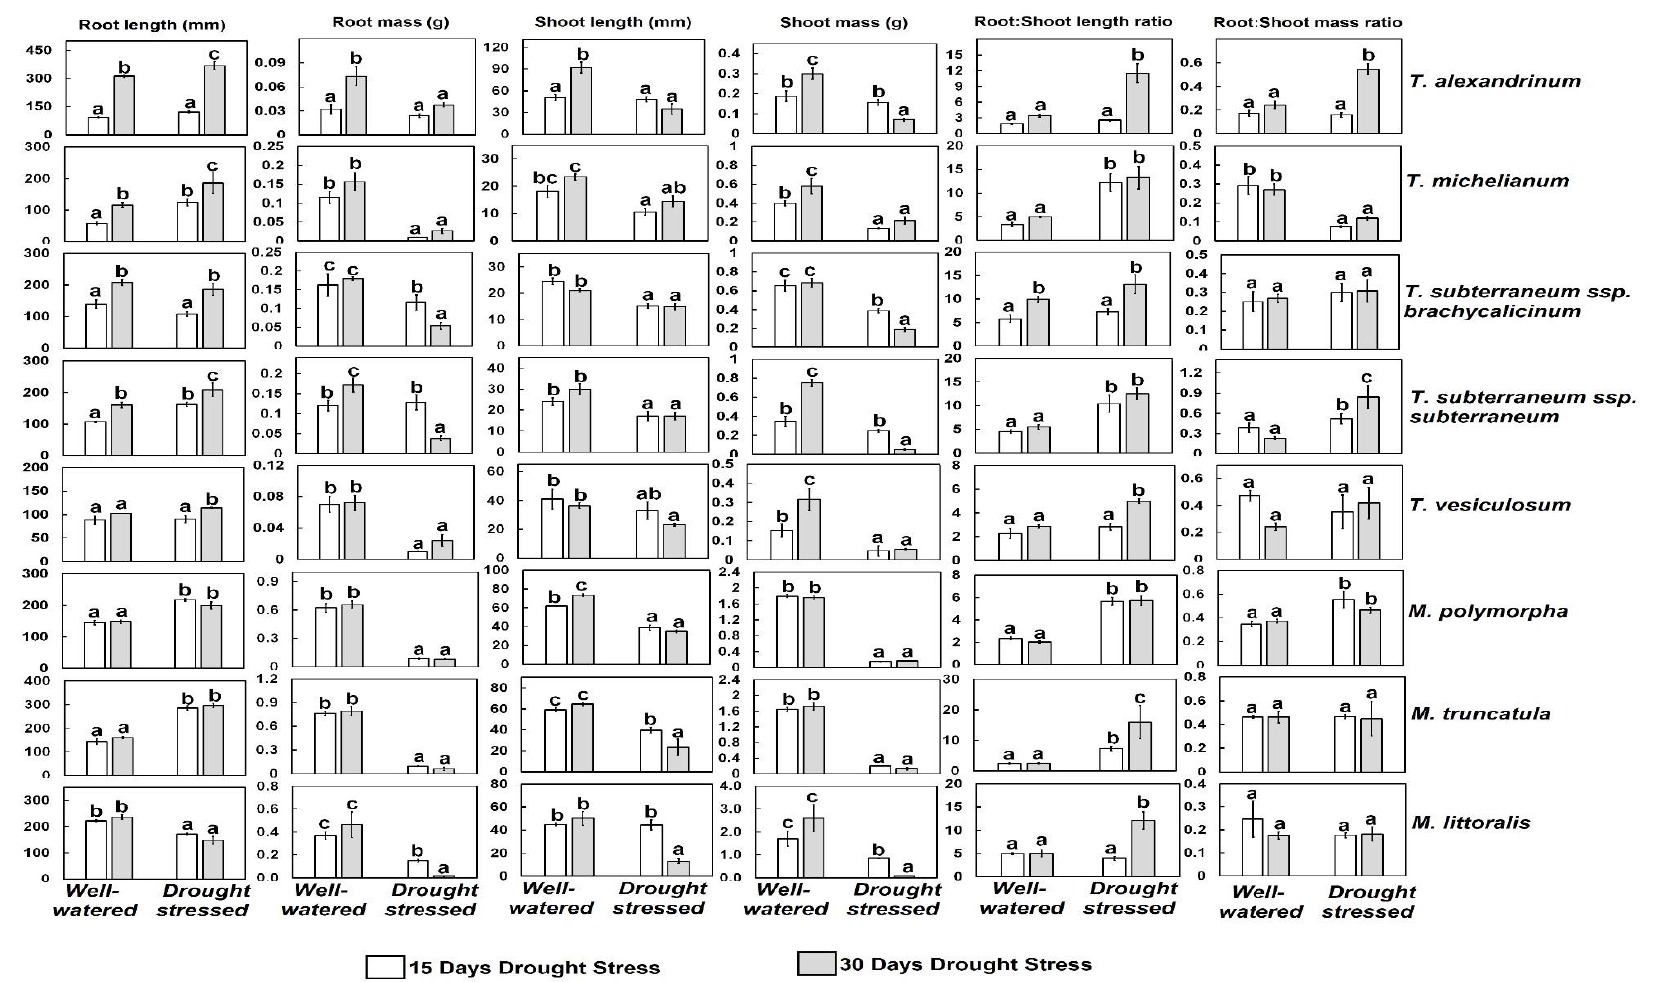
Figure 2. Morphological characteristics of annual medics and clovers subjected to 15 and 30 days of water limitation. Columns with error bars represent means ± SEMs. Comparisons are made within each species for each measured variable.